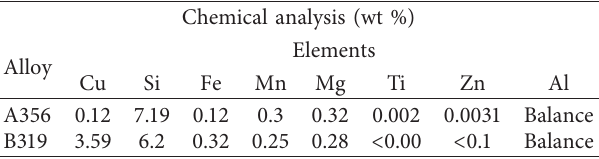
Table 1: Chemical composition of the as-received base alloys used in this